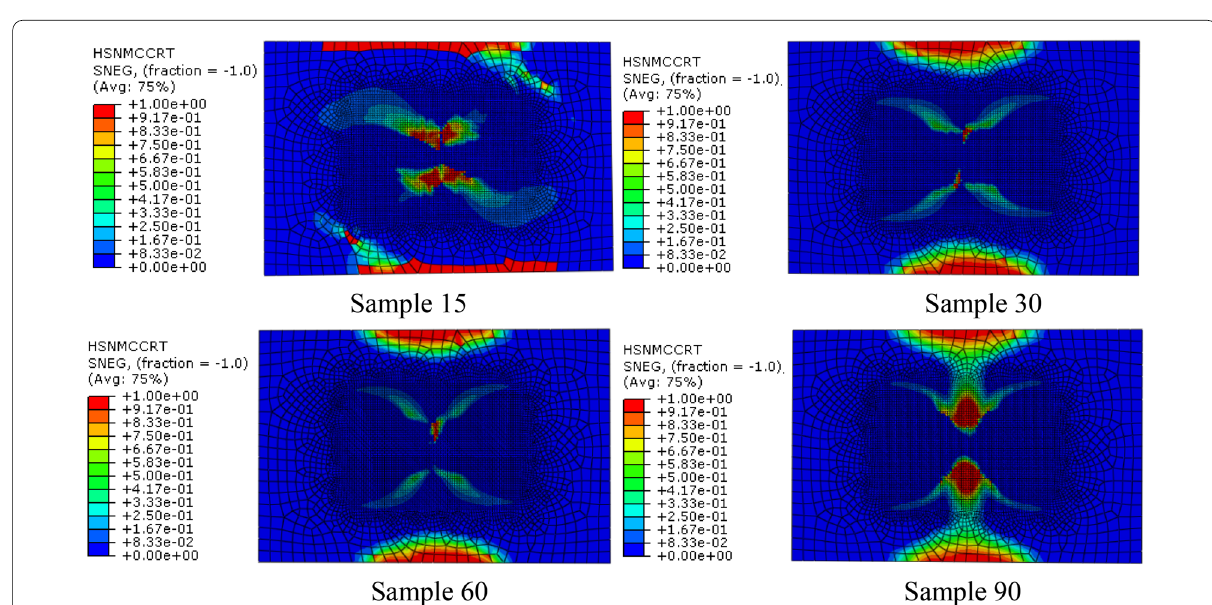
Fig. 9 Distribution nephogram of matrix compression failure of four bionic models with different helix angles when impact energy is 20